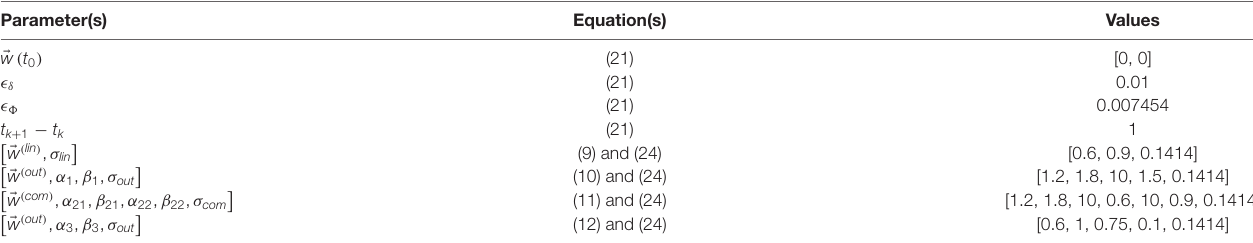
TABLE 2 | Standard set of